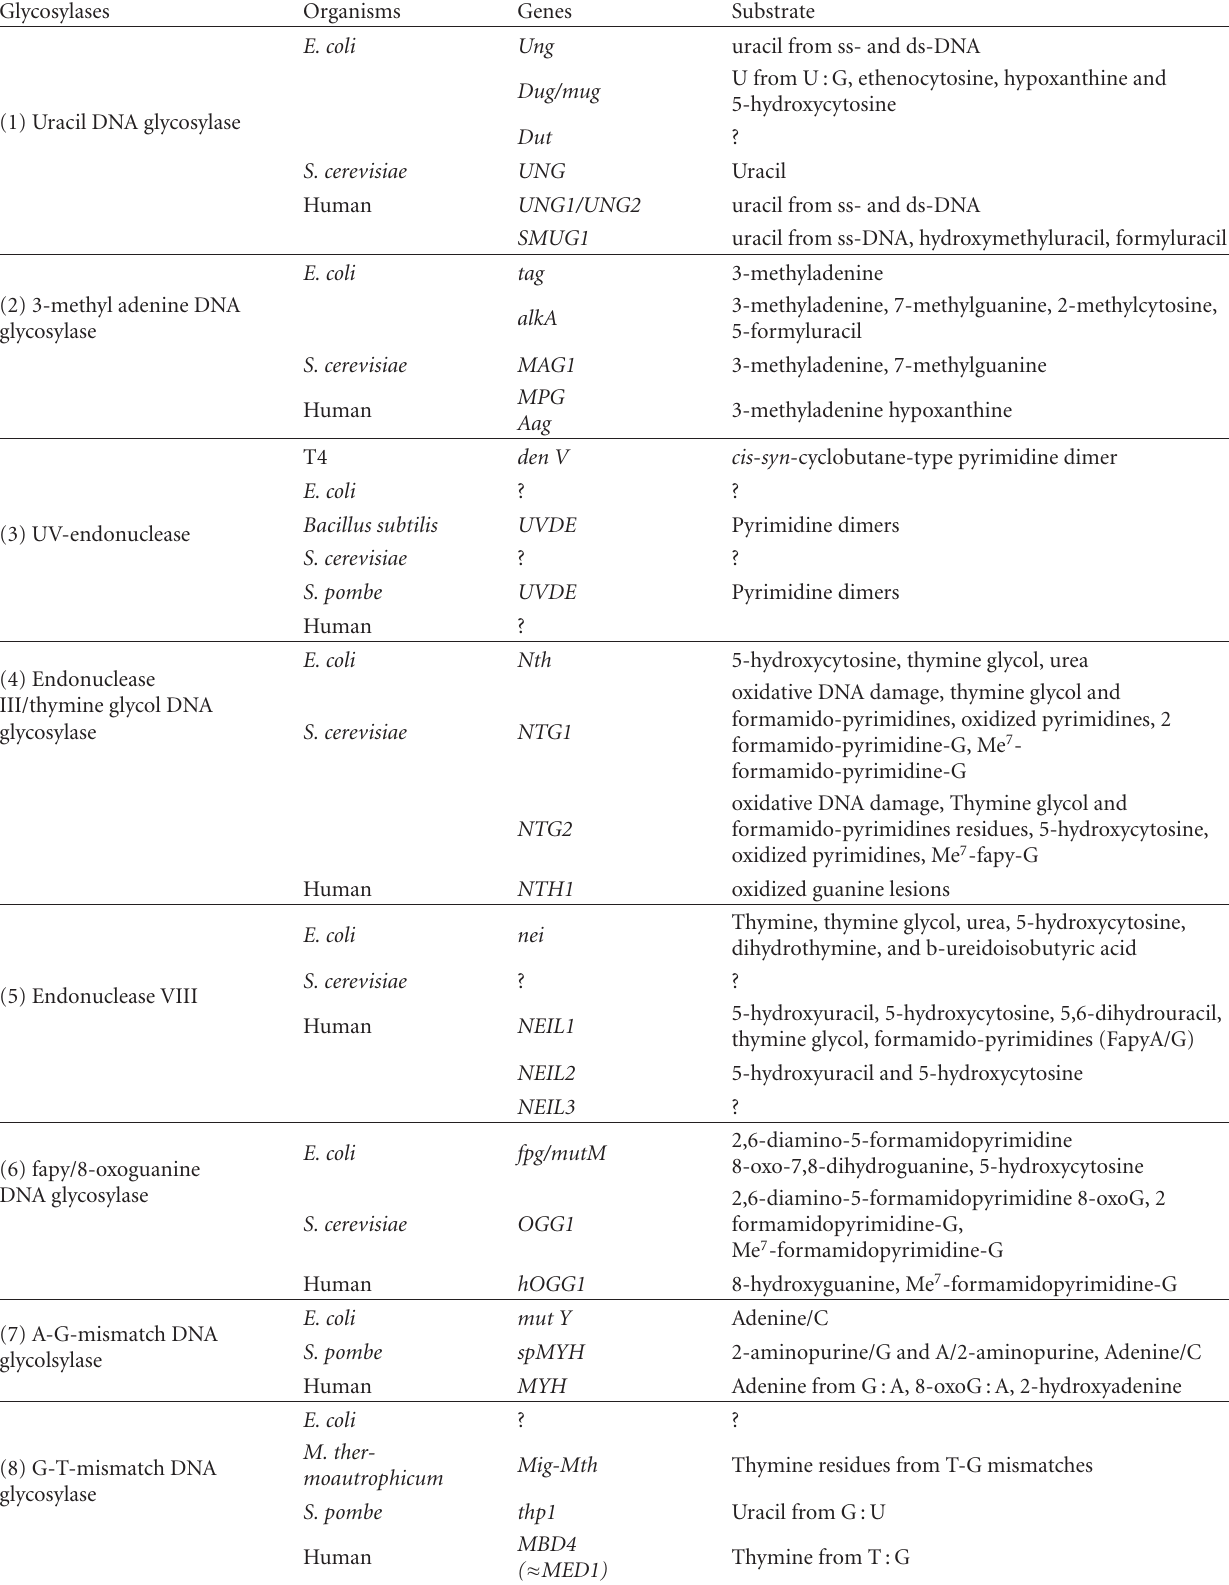
Table 3: DNA glycosylases and their probable substrate in bacteria, yeast, and human (modified from Sinha and H¨ader [22]).